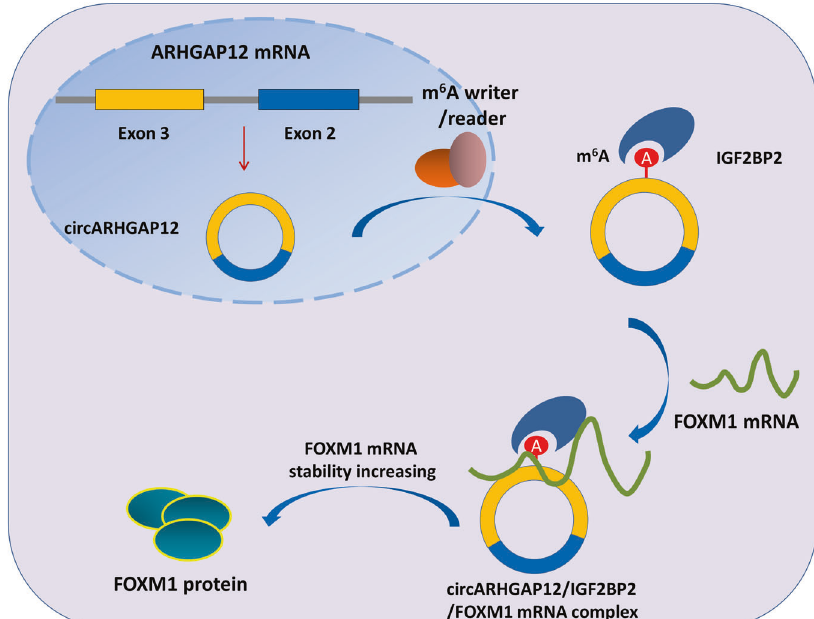
Fig. 6 m 6 A-modi fi ed circARHGAP12 promotes cervical cancer progression by enhancing FOXM1 mRNA stability via interacting